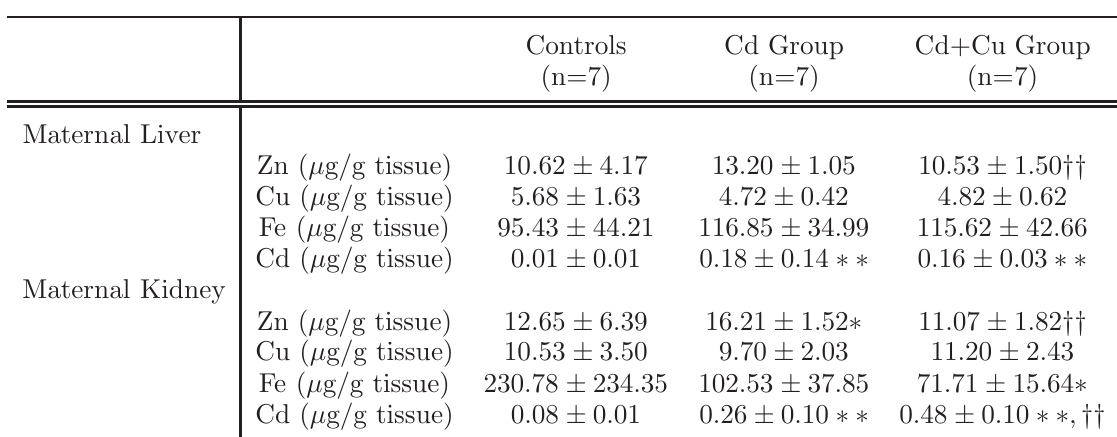
Table 4 Comparisons of element levels in maternal tissues (mean ±